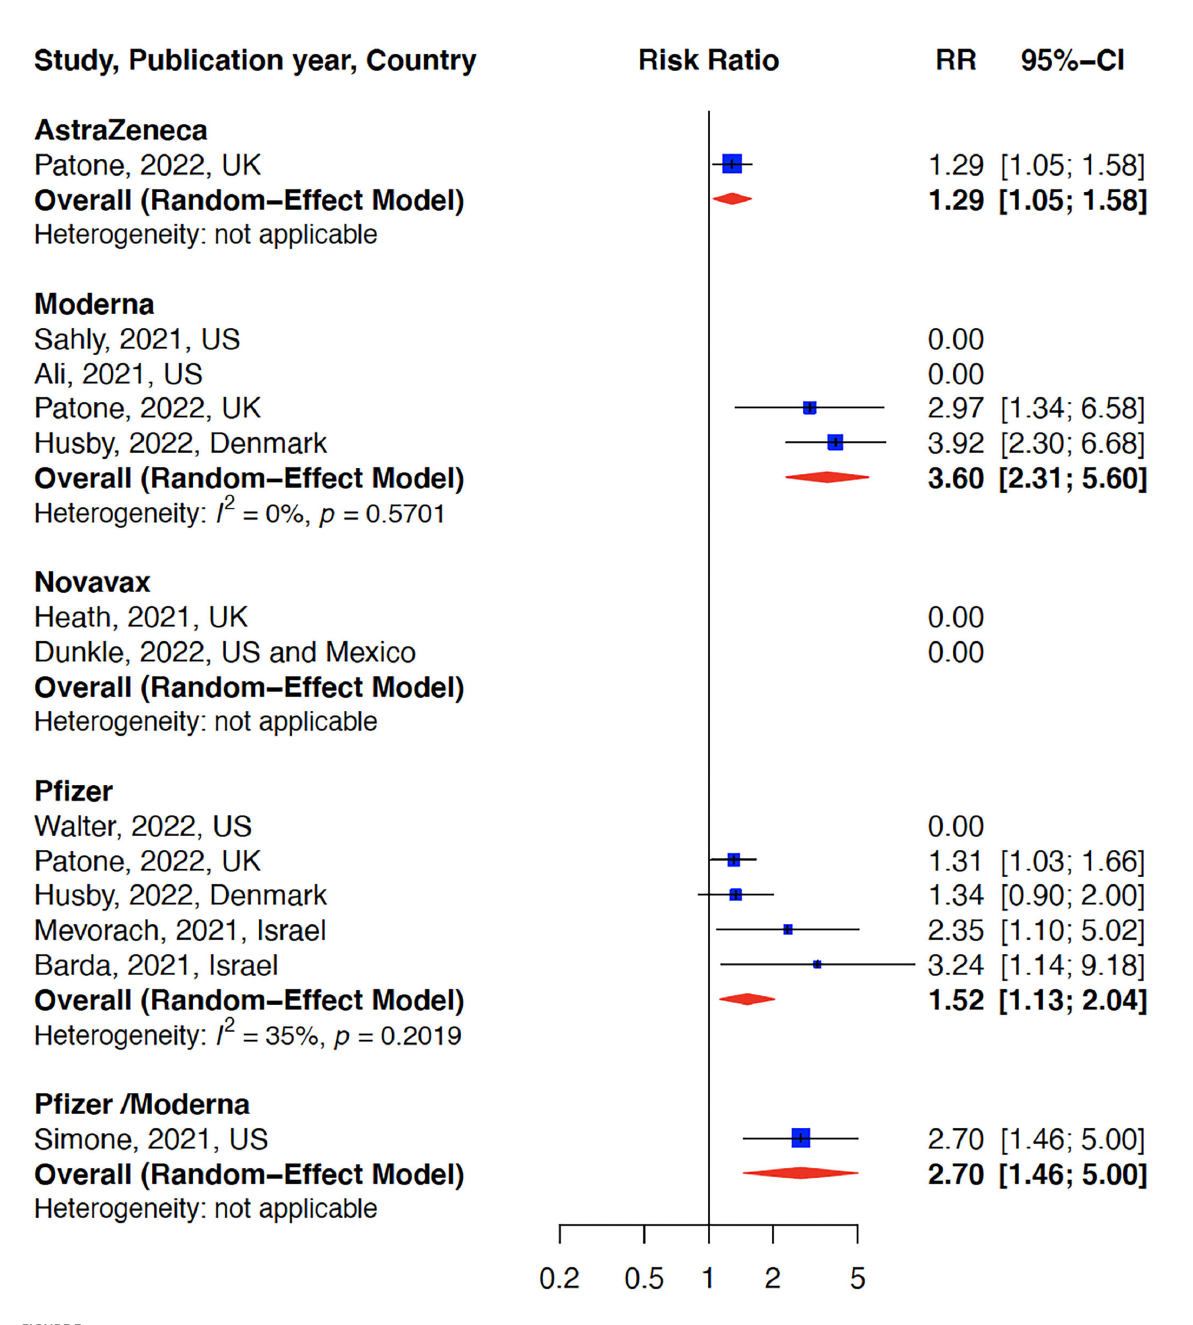
FIGURE3 Myocarditis after COVID-19 vaccination stratified by vaccine type. The risk of myocarditis was highest in the Moderna vaccine group.